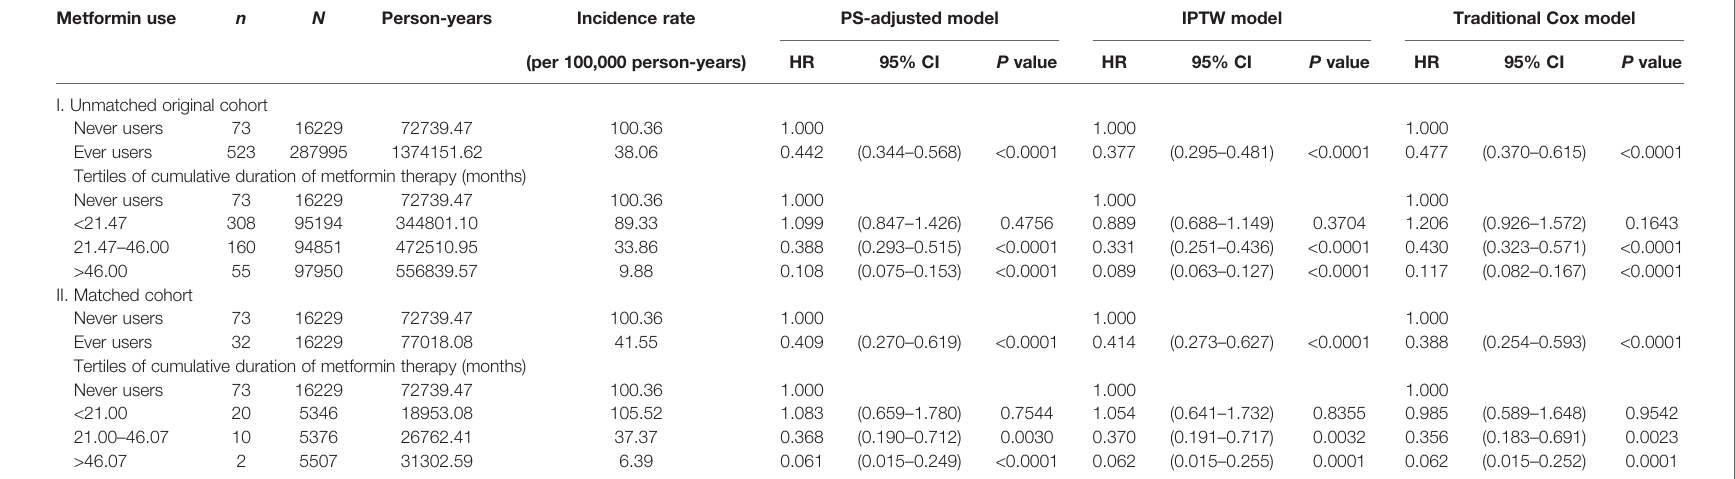
TABLE 2 | Incidence rates of biliary tract cancer and hazard ratios by metformin exposure in the main analyses.